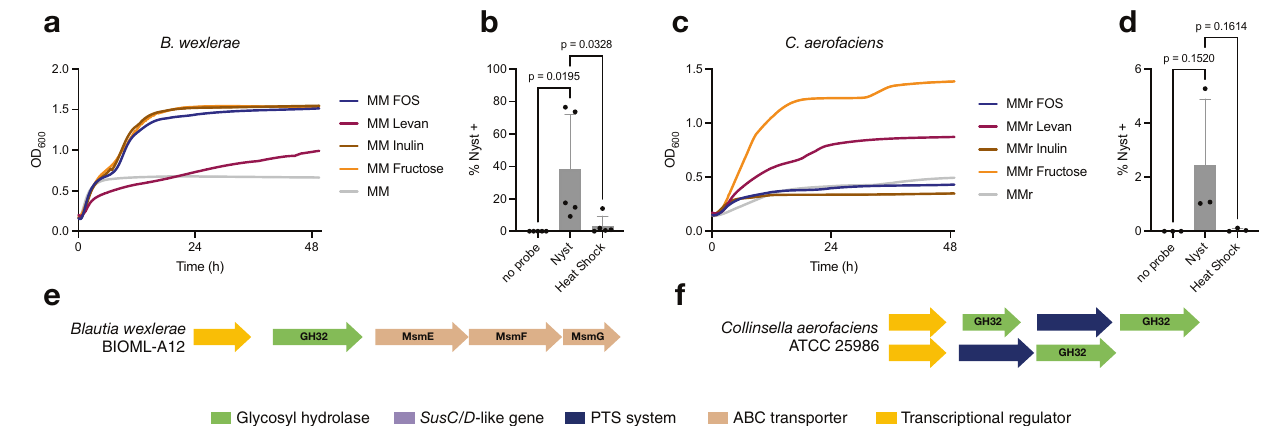
Fig. 4 | Blautia wexlerae and Collinsella aerofaciens are FOS and levan con- sumers, respectively. Growth of B. wexlerae ( a ) and C. aerofaciens ( c ) in MM supplemented with different fructooligosaccharides for 48h. The viability of bac- teria was evaluated by growth in MM supplemented with fructose. All growth measurements are the means of triplicates. Exponential cultures of B. wexlerae ( n =5) ( b ) and C. aerofaciens ( n =3) ( d ) in MM supplemented with FOS were incu- batedfor1hwith NYST-F.The percentageofNYST + bacteria wasmeasured by fl ow cytometry. Data from three to fi ve independent experiments are shown as the